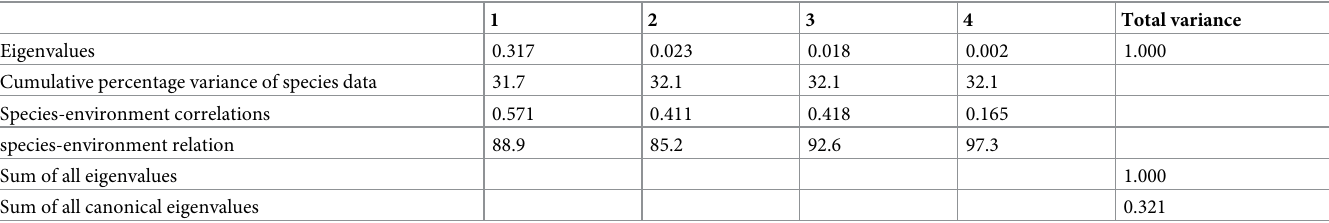
Table 1. Summary of Redundancy Analysis (RDA) soil ecological stoichiometry and nutrient concentration in various organs.